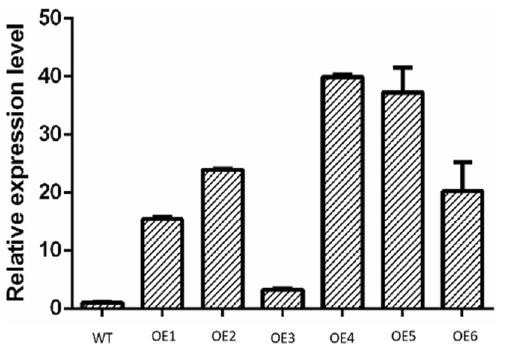
Figure 9. Relative expression levels of p1302 -LoHDZ2 in transgenic tobacco. WT: wild tobacco; OE2-OE5: different transgenic